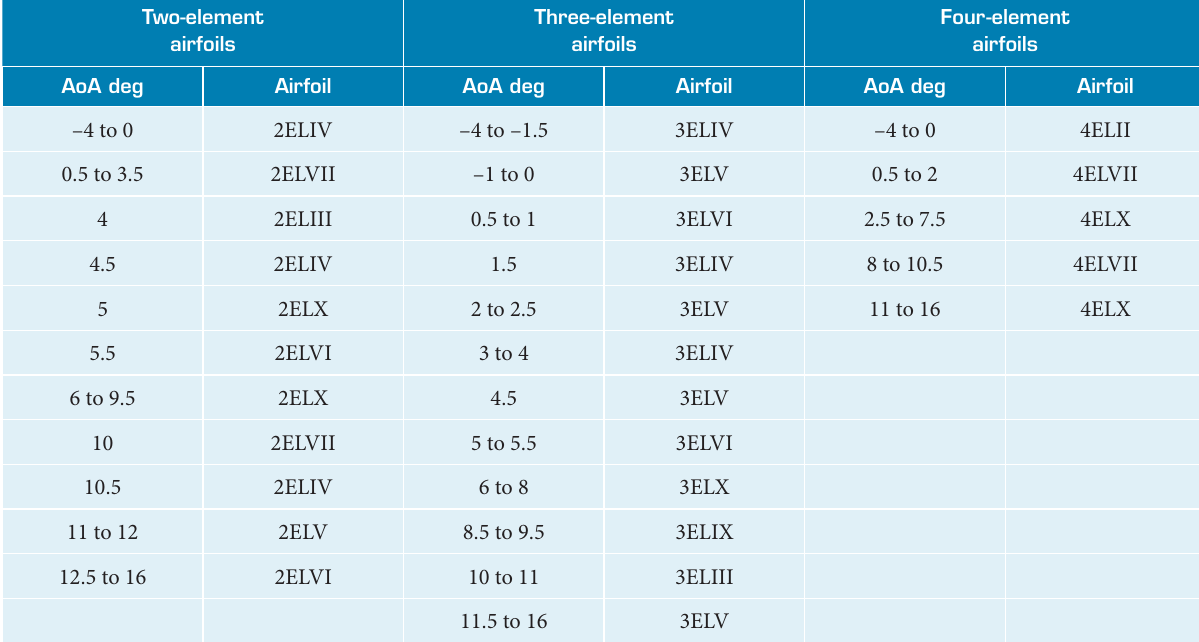
/ c ratio for Re = 4.8 × 10 5 l d